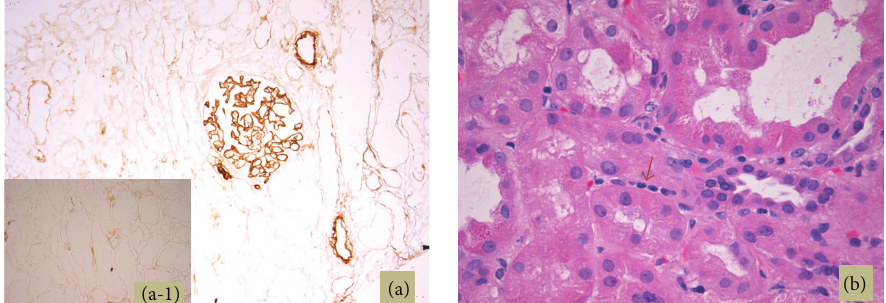
Figure 5: C4d immunostaining shows no staining of interstitial capillaries. There is positive staining of glomeruli and arteries endothelial lining, which is a normal internal control finding on cryostat sections immunostained with the C4d antibody (Quidel, San Diego, CA) ((a) including high magnification inset (a-1)) (immunohistochemistry). Only rare capillaritis was observed ((b) red arrow) (hematoxylin and eosin stain).